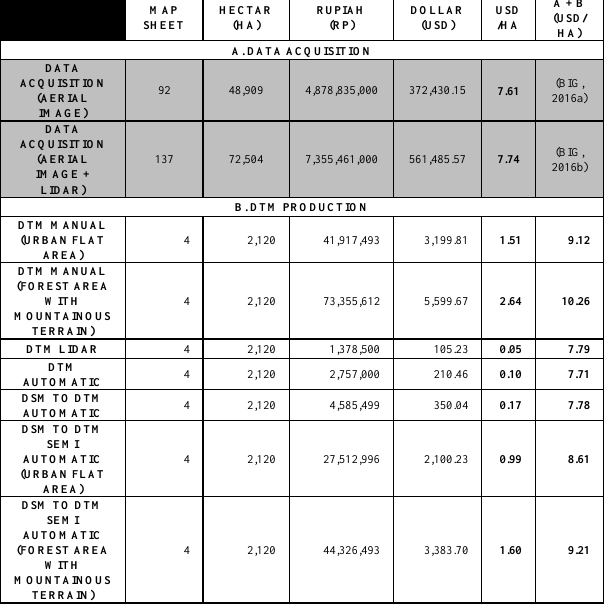
Table 1. Production cost